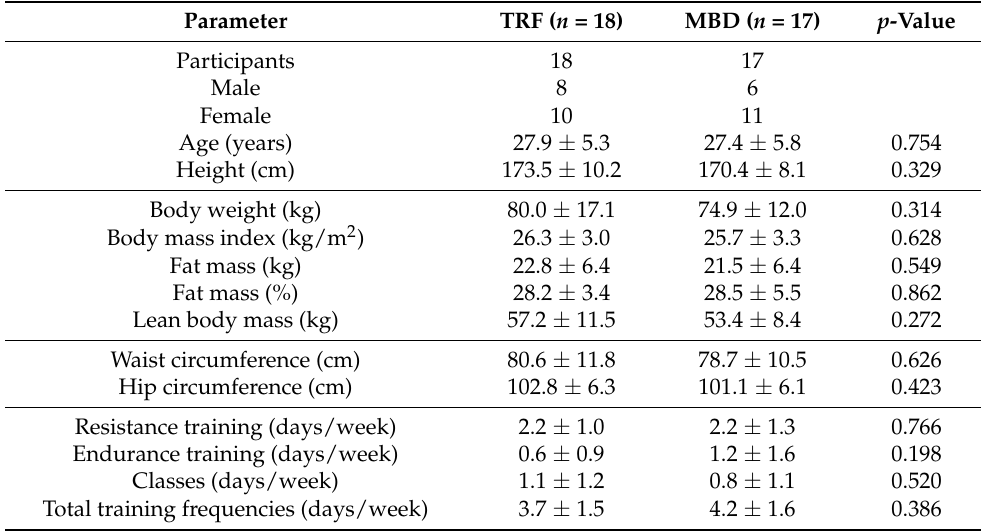
Table 1. Subject characteristics at time T0 ( n = 35).